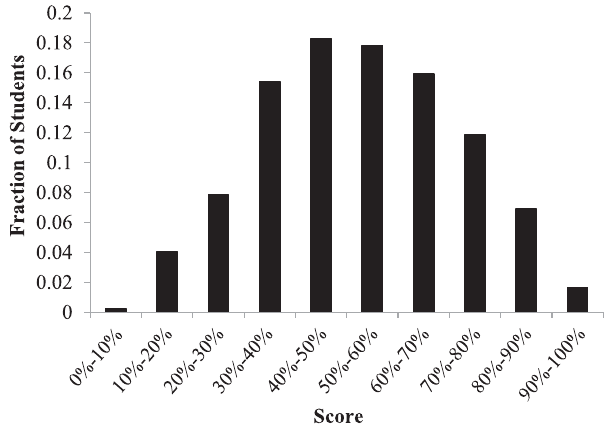
FIG. 3. Average scores for each item on the CMR CUE ( N ¼ 421 ). Error bars represent a 95% confidence interval (double the standard error on the mean). Score distributions for each individual item are not necessarily normally